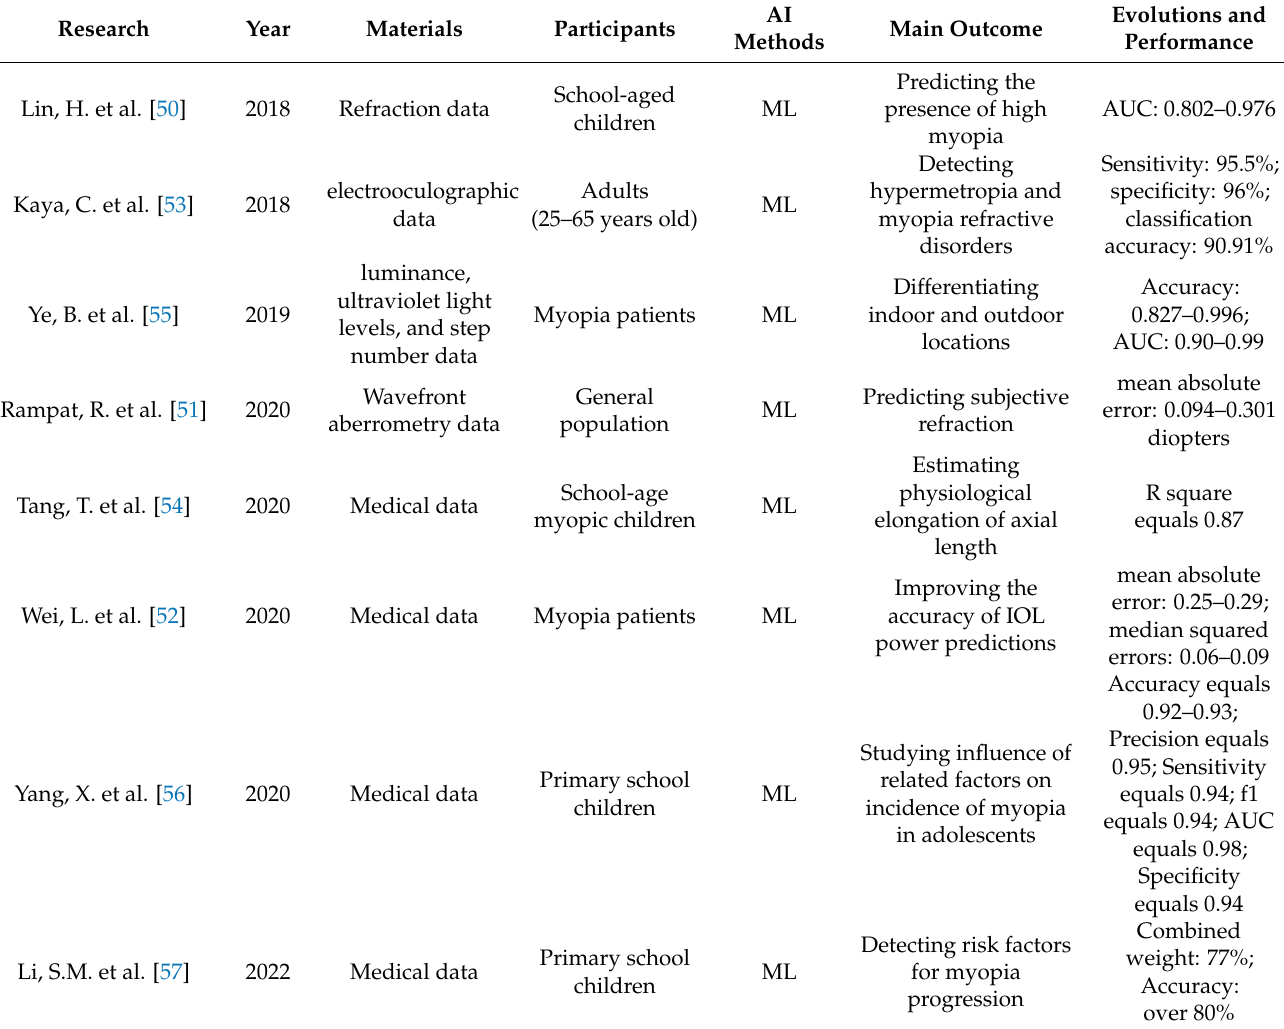
Table 1. Data-driven artificial intelligence (AI) models in high myopia and pathologic